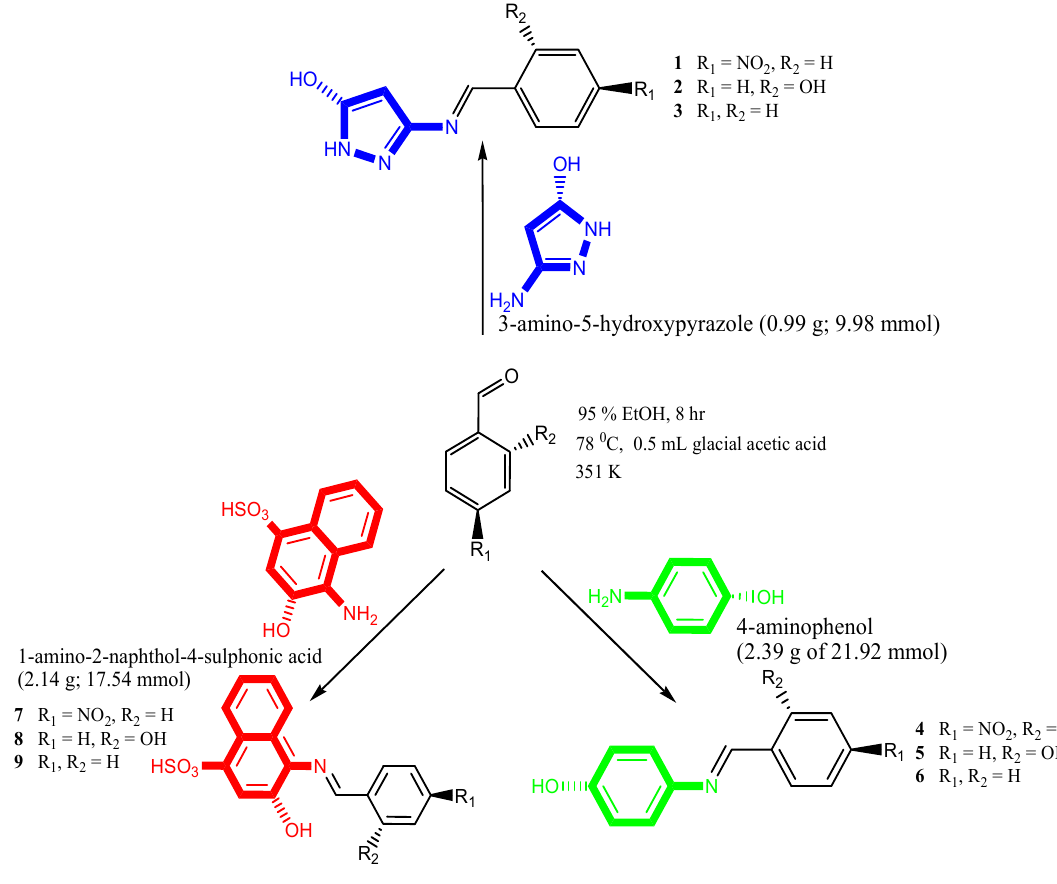
Figure 1. Synthetic route for compounds 1 – 9 .